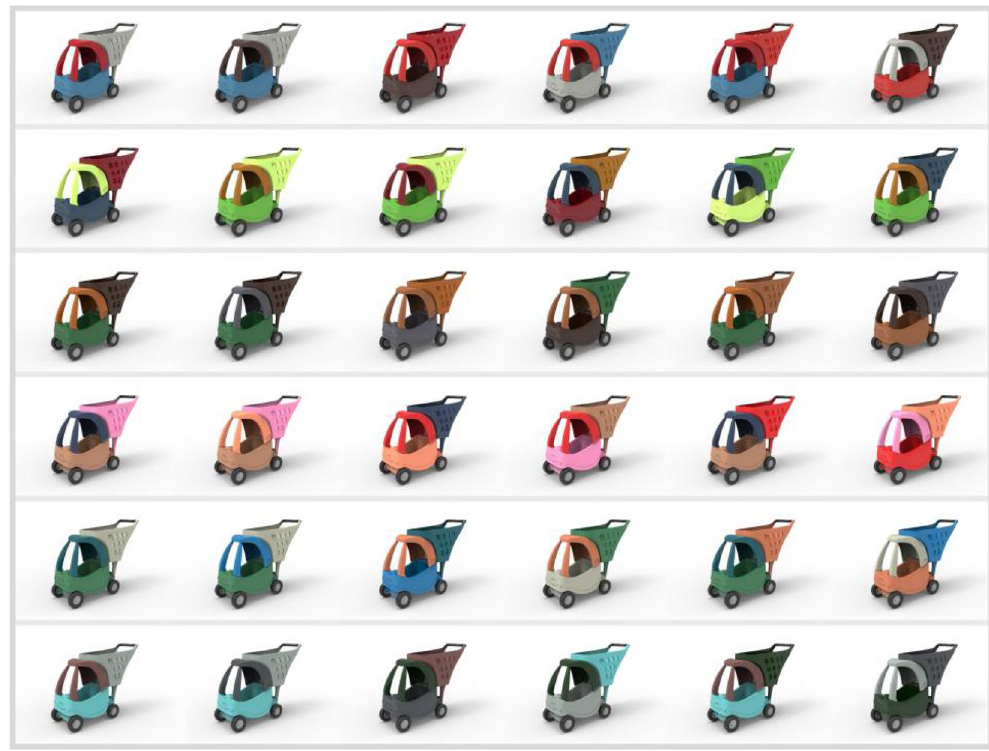
Figure 2. Part of the 360 color design schemes of the three-color children’s shopping cart.